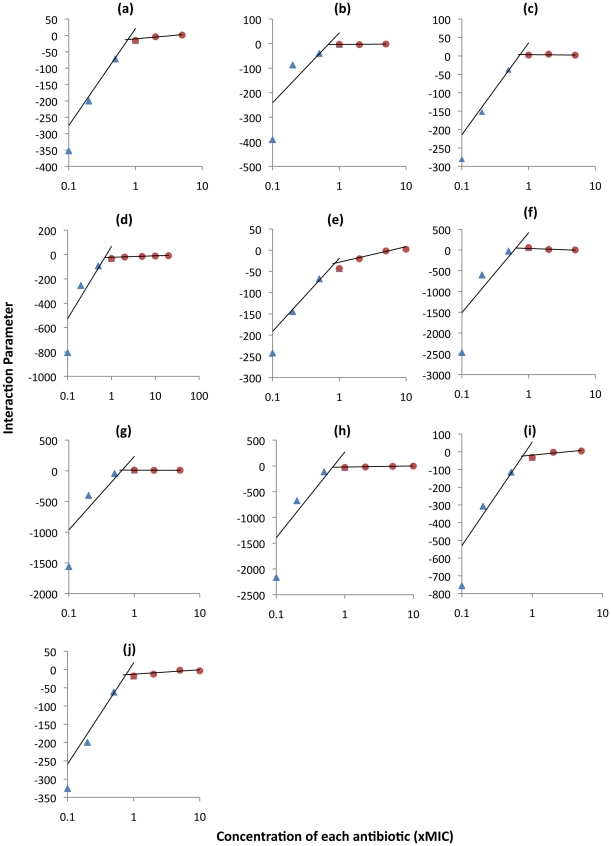
The interaction parameter as a function of antibiotic concentration.Independent linear regressions are shown for sub-MIC (triangles) and supra-MIC (circles) concentrations. (a) amikacin + clarithromycin (b) amikacin + moxifloxacin (c) amikacin + streptomycin (d) clarithromycin + moxifloxacin (e) clarithromycin + streptomycin (f) rifampin + amikacin (g) rifampin + clarithromycin (h) rifampin + moxifloxacin (i) rifampin + streptomycin (j) streptomycin + moxifloxacin.